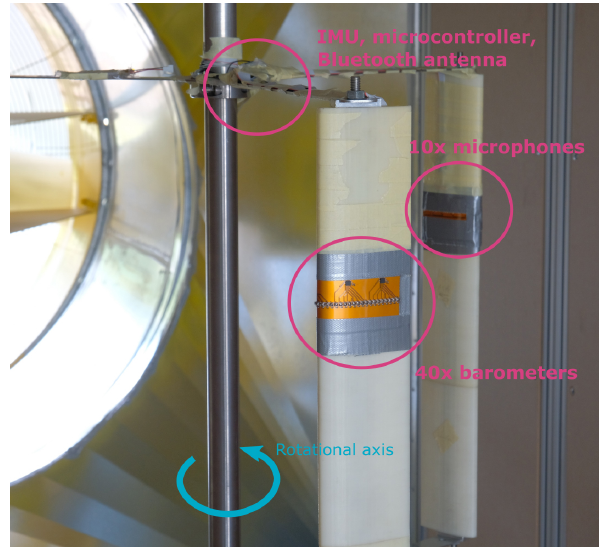
Figure 6. Layout of the first version of the Aerosense system on a vertical axis wind turbine in the OST wind